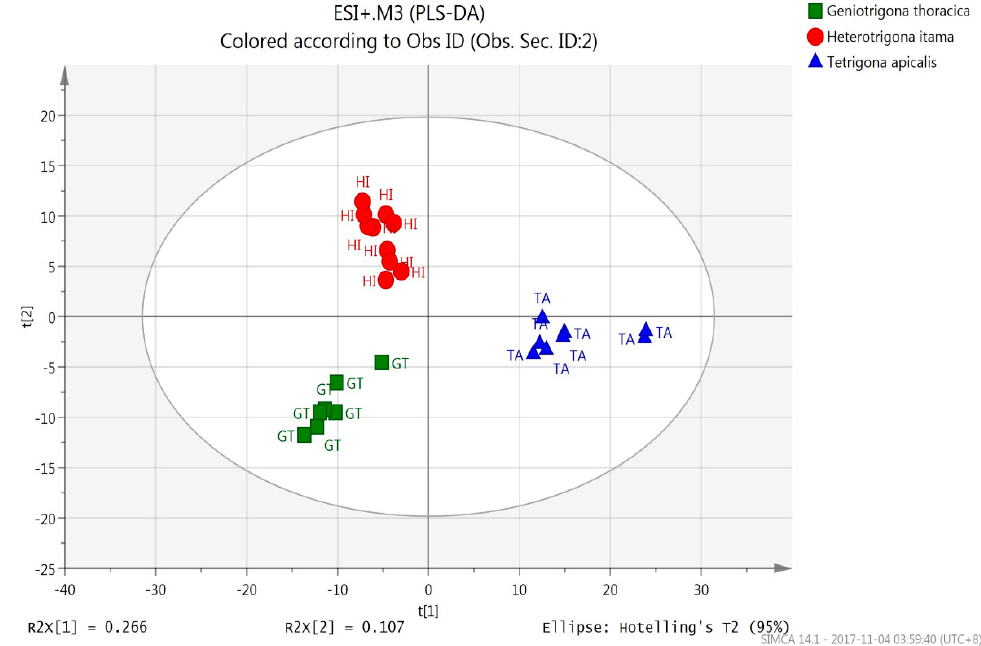
Figure 2. PLS-DA score scatter plot for m / z values of ESI + precursor ions by UHPLC-QTOF MS data.